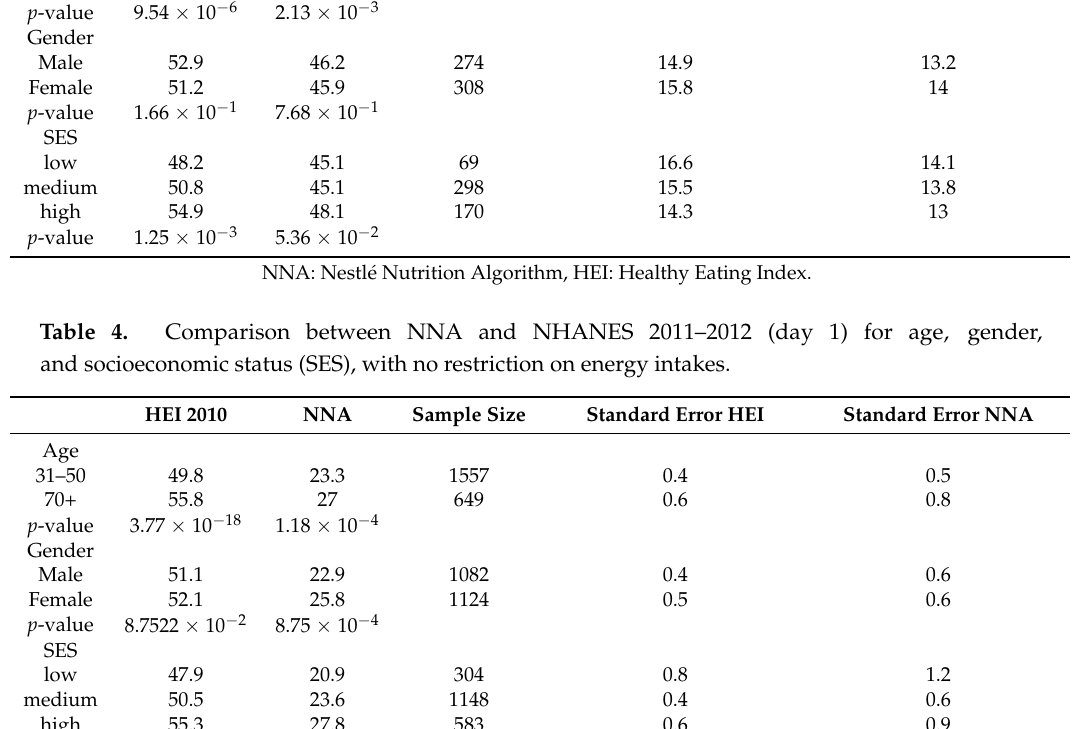
NNA: Nestl é Nutrition Algorithm, HEI: Healthy Eating Index.